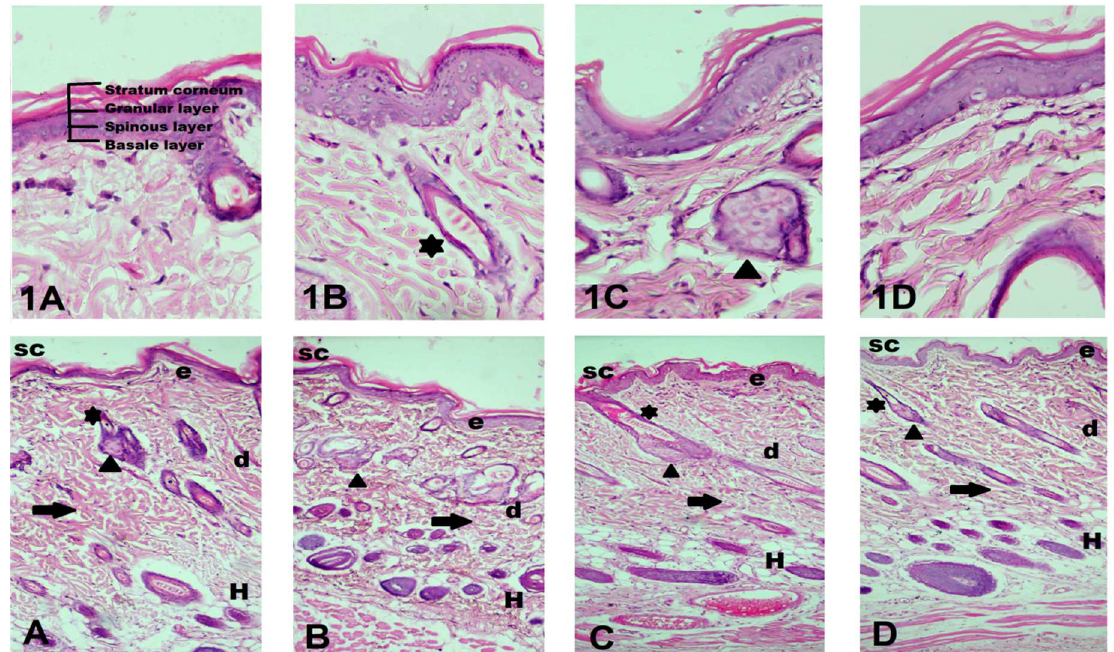
Figure 5. Histopathological examination of rat skin at 10 × and 40 × magnification. ( A , 1A ) Group 1 no application; ( B , 1B ) Group 2 Blank NEG; ( C , 1C ) Group 3 NEG-1; ( D , 1D ) Group 4 NEG-1 (IC). Skin structures: (SC) stratum corneum; (d) dermis; (H) hypodermis; (*) hair follicle; (arrow head) sebaceous gland; arrows indicate collagen fibers.